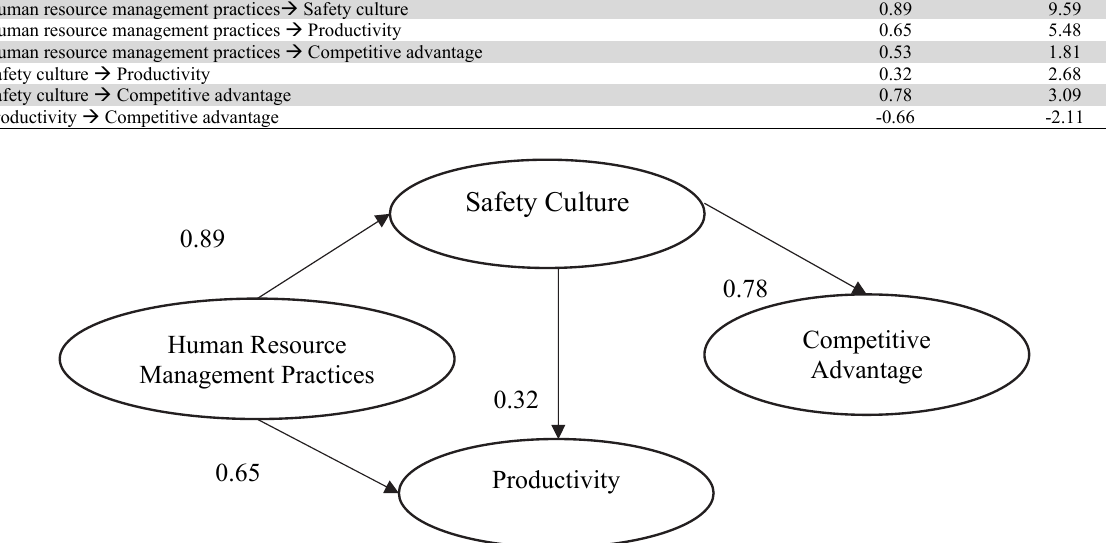
Fig. 4. The results of structural